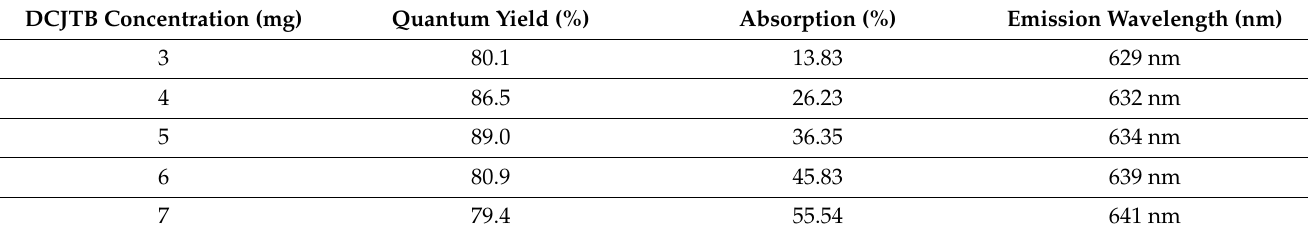
Figure 3. ( a ) Quantum yield profile of coumarin-6-based fluorescent film at different concentrations and ( b ) film morphology of coumarin-6 at different concentrations. Table 1. Quantum yield and absorption of the different concentrations of